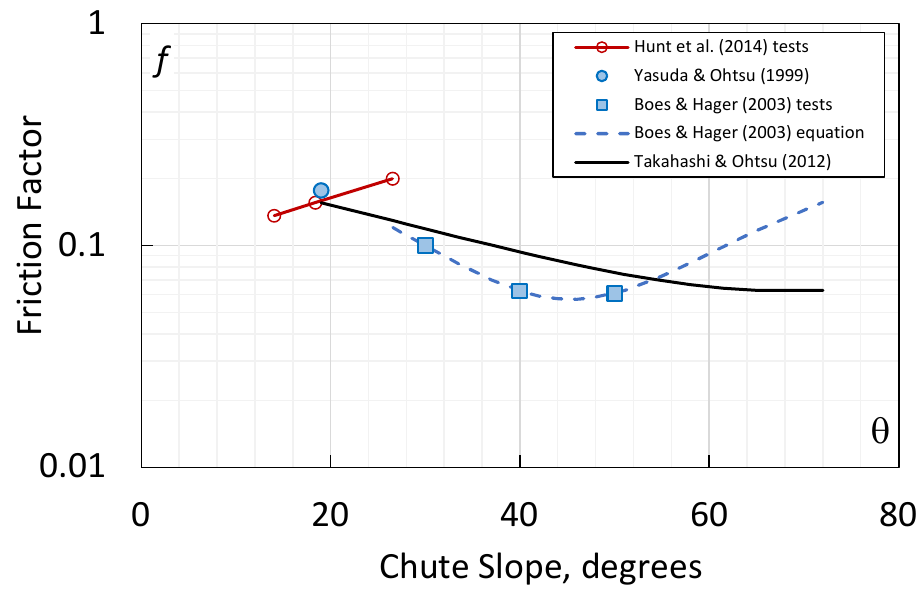
Figure 6. Friction factors for the fully aerated region of stepped chutes vs. chute slope [18,22,45,59].